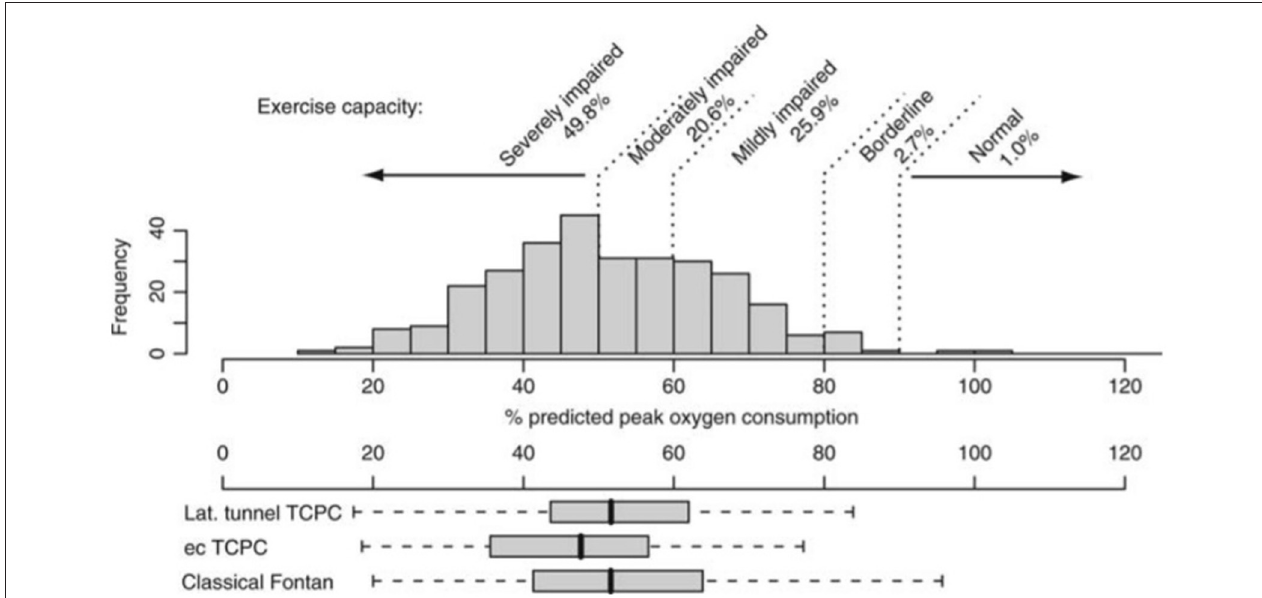
FIGURE 1 | Distribution of % predicted peak oxygen uptake (consumption) in patients after Fontan operation and its distribution in patients with different types of Fontan surgery. ec, extracardiac; lat, lateral; TCPC, total cavopulmonary connection. Reproduced from